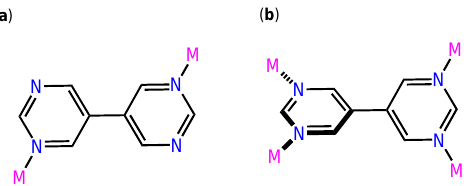
Scheme 1. ( a ) The linear trans - µ 2 - N , N (cid:48) -bpym in Compound 1 ; ( b ) the twisted µ 4 - N , N (cid:48) , N (cid:48)(cid:48) , N (cid:48)(cid:48)(cid:48) -bpym Compound 2 . in Compound 2 . Compound 2 . Compound 2 .